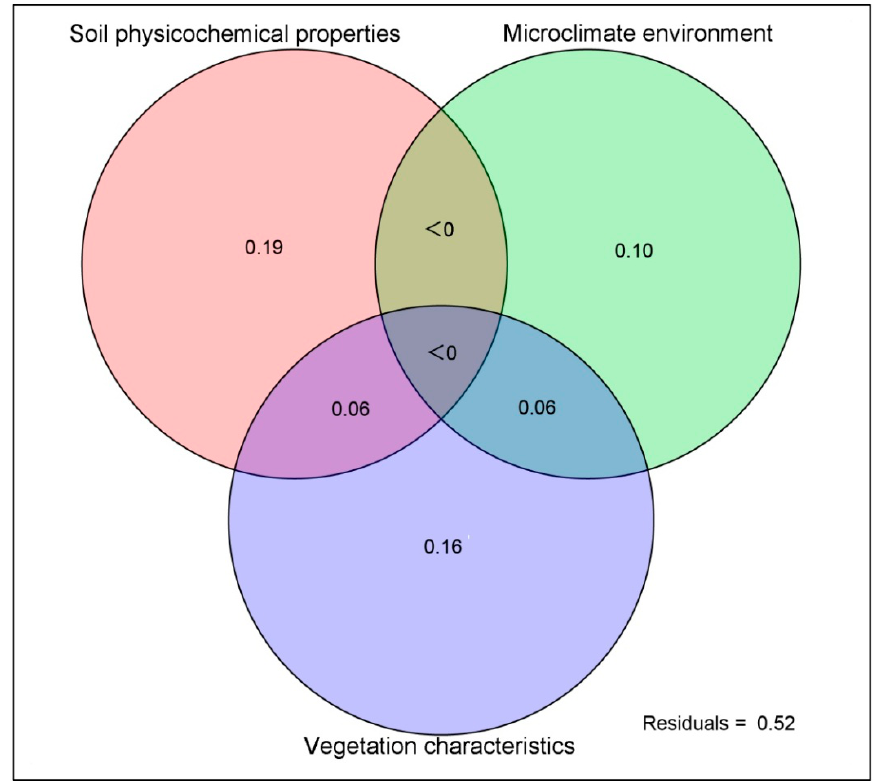
Figure 8. Variance partitioning analysis based on the percent relative abundance of the all genus-level classifications. Soil physicochemical properties, vegetation characteristics, and microclimate environment are represented by the variance explained by soil physicochemical properties alone, vegetation characteristics alone, microclimate environment alone, or soil physicochemical properties, vegetation characteristics, and microclimate environment together. Residuals represent the variance that could not be explained by either pollutants or meteorological factors. Forward selection was performed before VPA to select significant